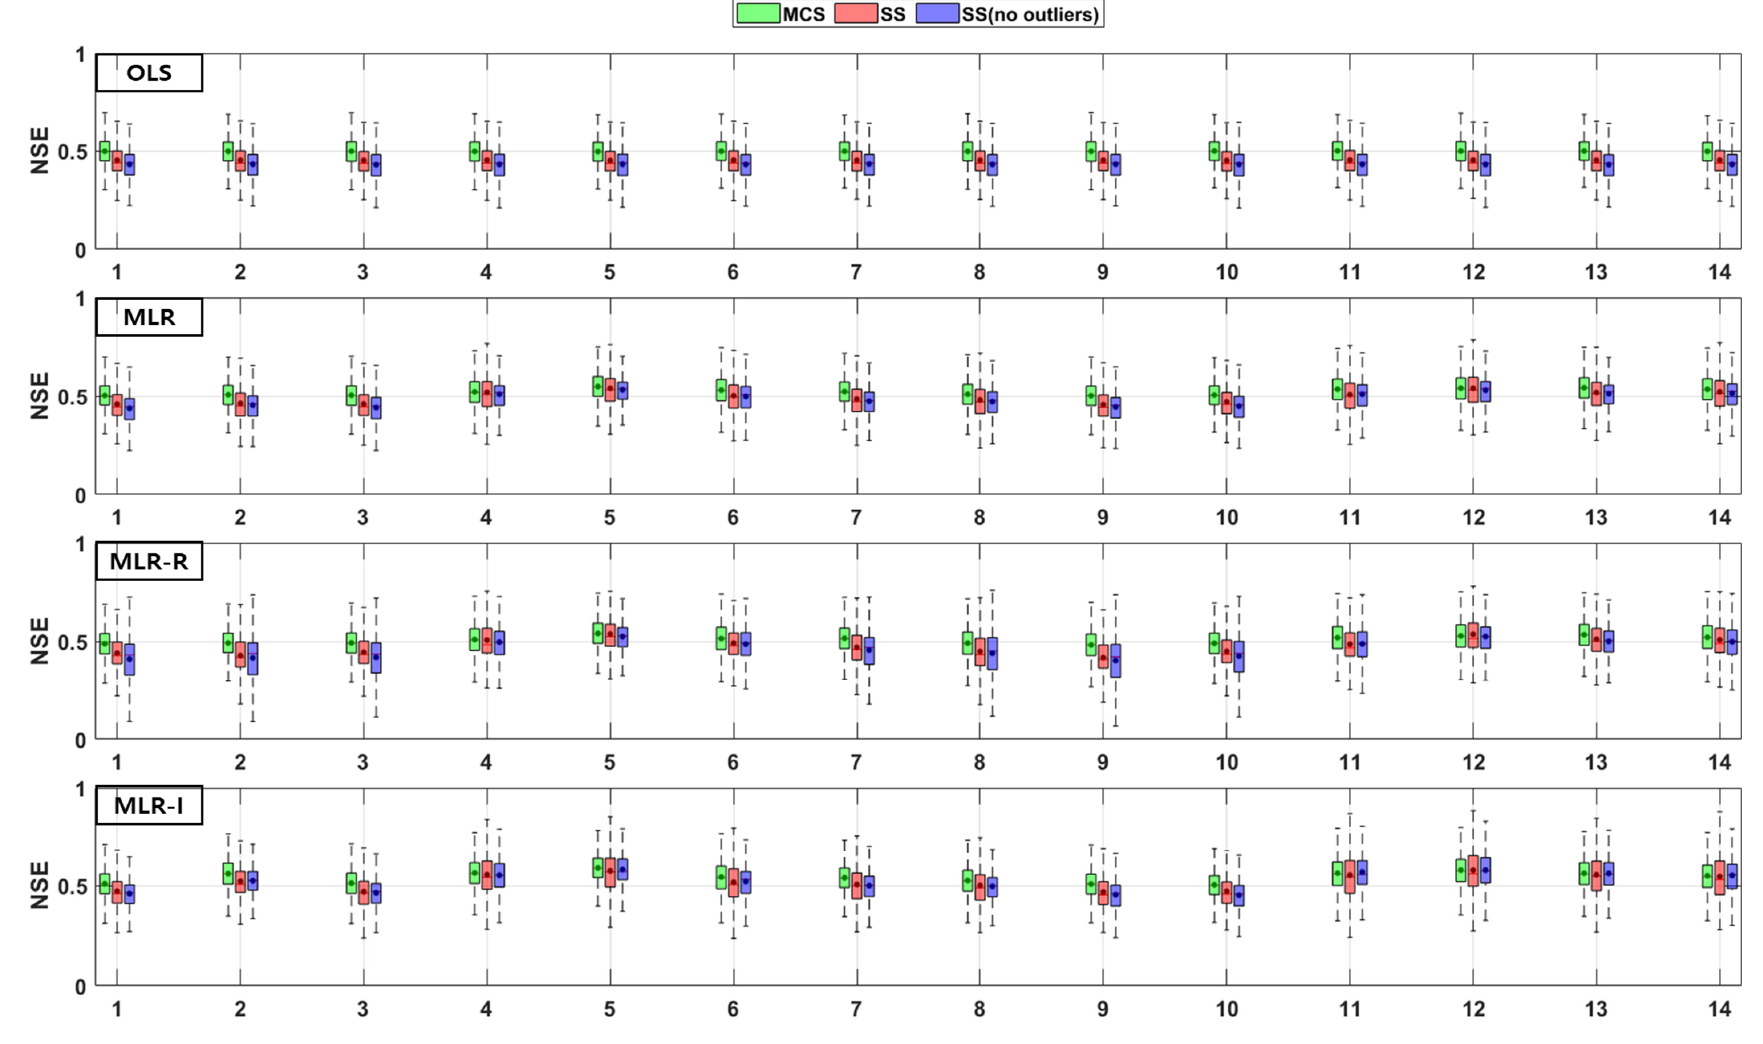
Figure 9. Error analysis (NSE) results of TP removal in detention basins.